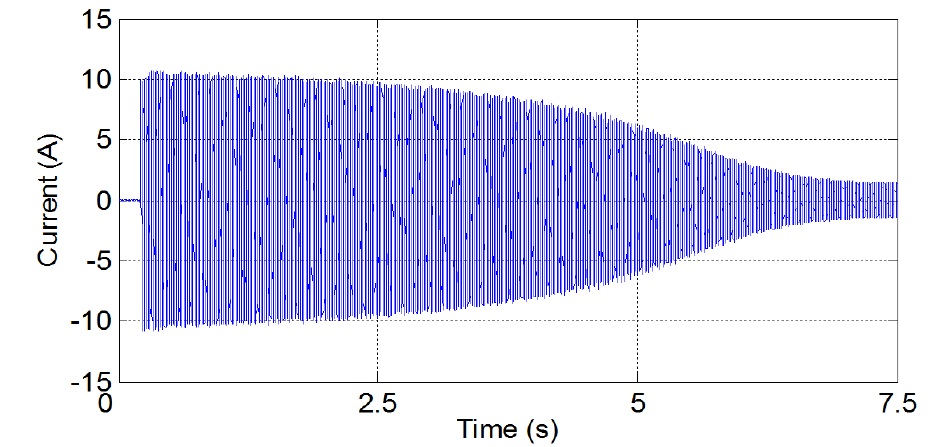
Figure 9. Tested start-up current of the machine with one broken bar.